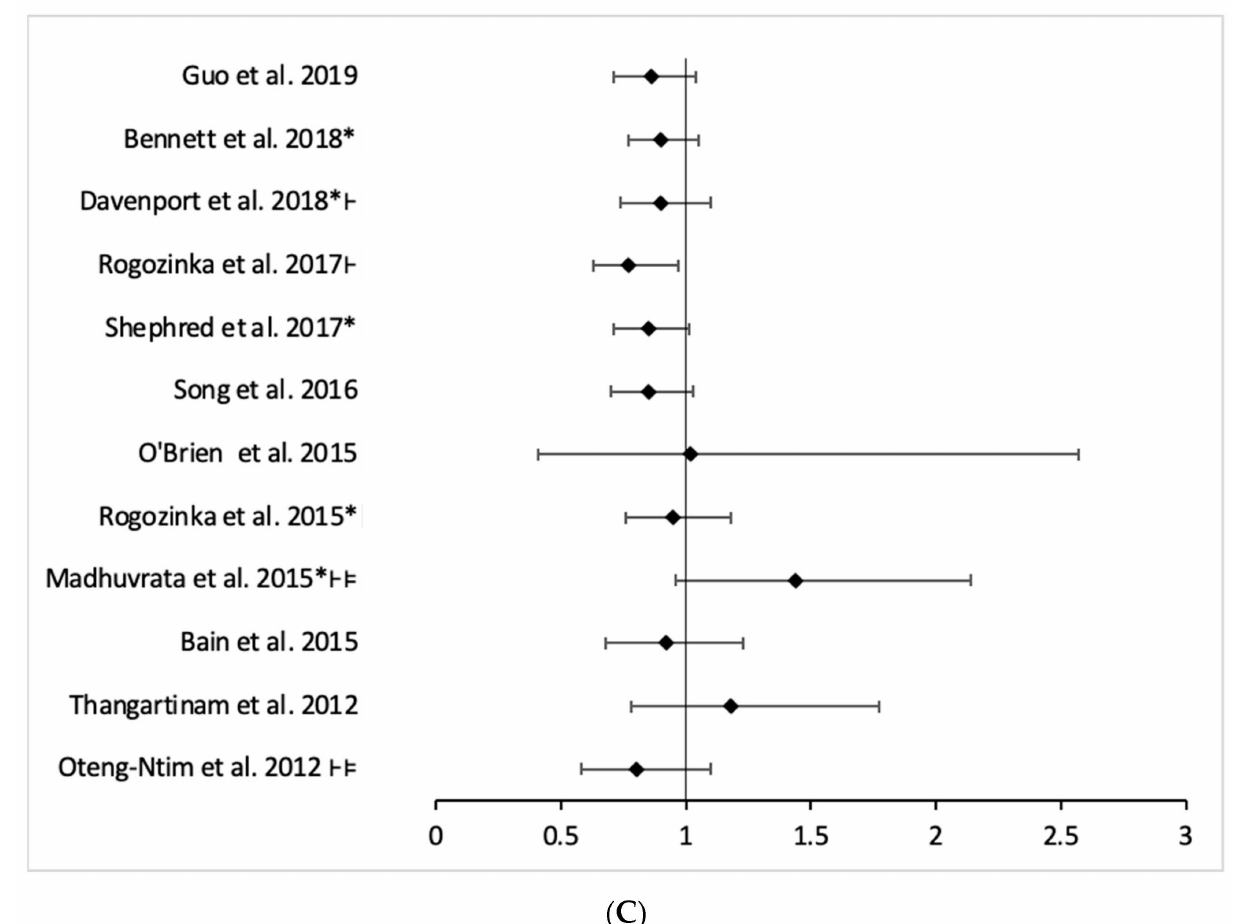
Figure 3. Forest plot of association of lifestyle intervention in reducing the risk of GDM. ( A ) Physical activity intervention. ( B ) Diet intervention. ( C ) Mixed intervention. * Moderate to high-quality re- view; ⊦: Odds Ratio; and ⊧: Women at high risk.